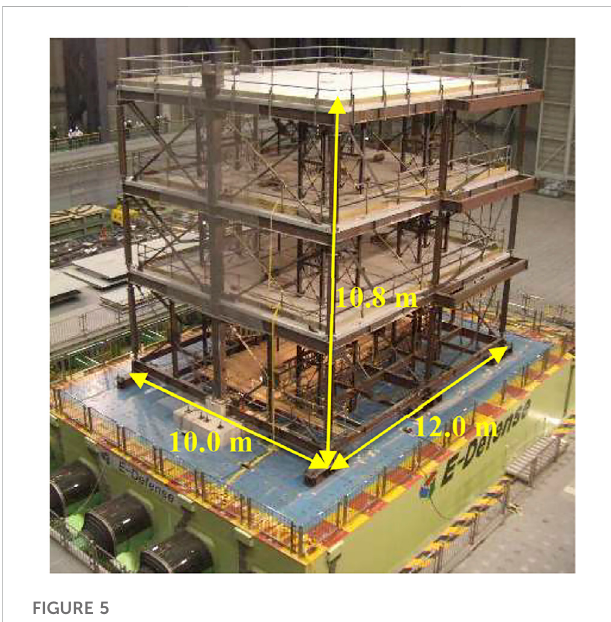
FIGURE 5 Three-storey steel structure tested by